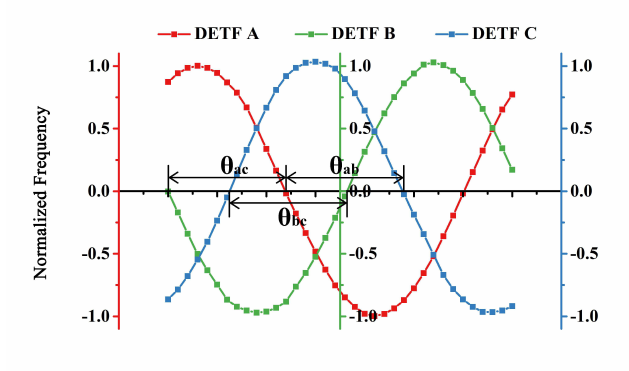
Figure 9. Normalized Frequency of the three DETFs.